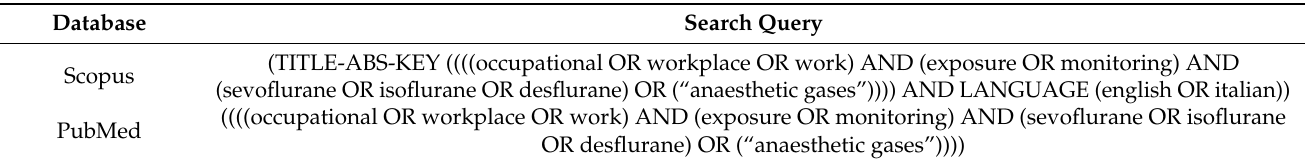
Table 2. Search query arranged for each database (last search: 1 October 2021). Database Search